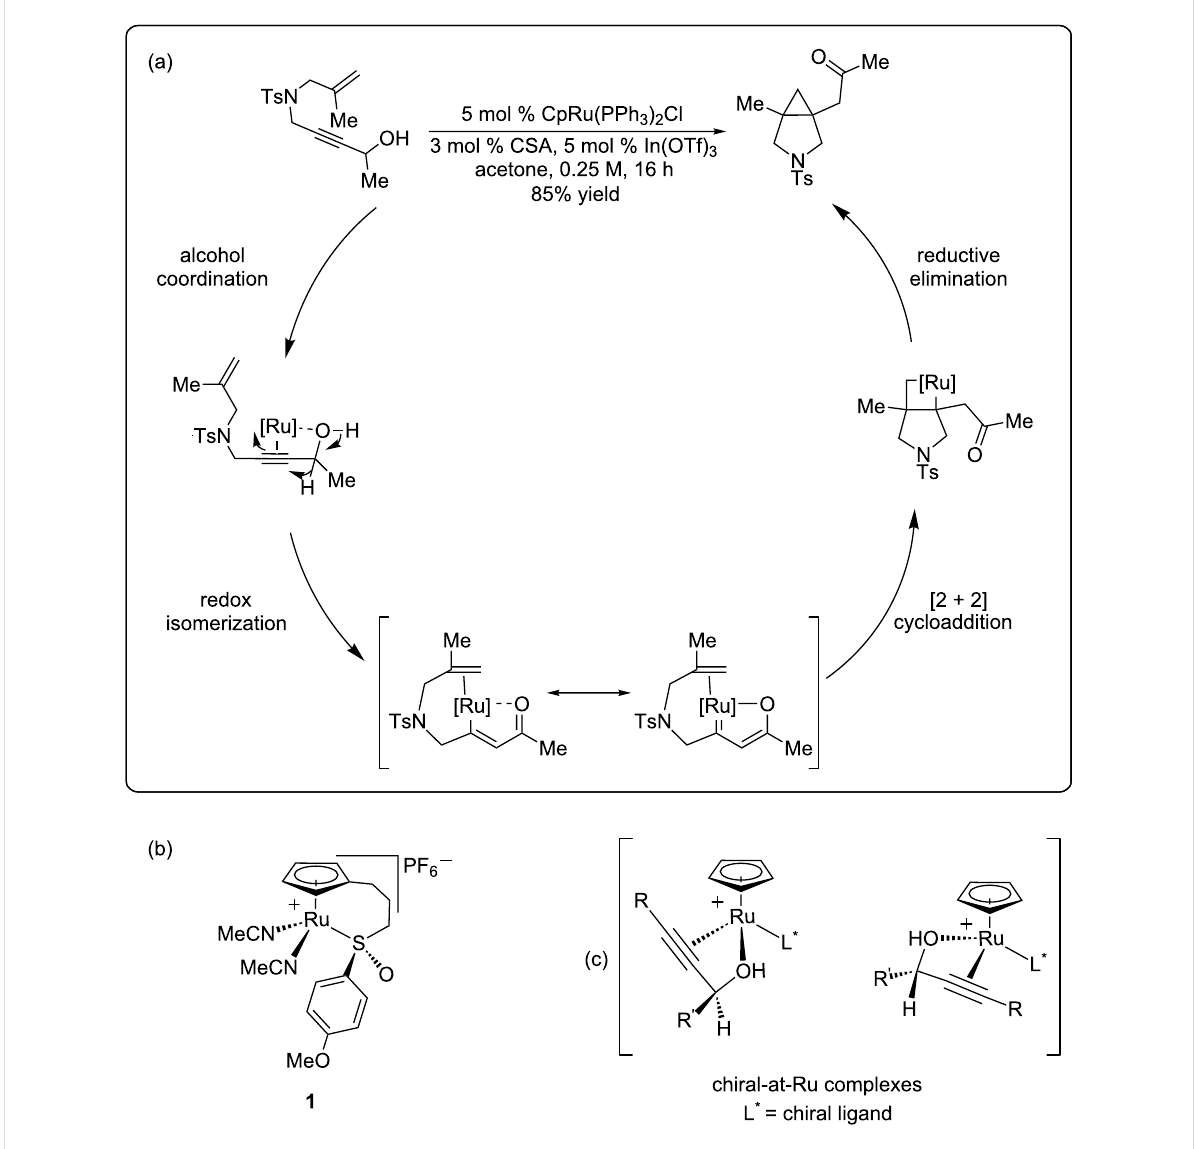
Figure 1: (a) Mechanism for the redox biscycloisomerization reaction. (b) Ruthenium catalyst containing a tethered chiral sulfoxide. (c) Possible dia- stereomeric complexes formed from alcohol